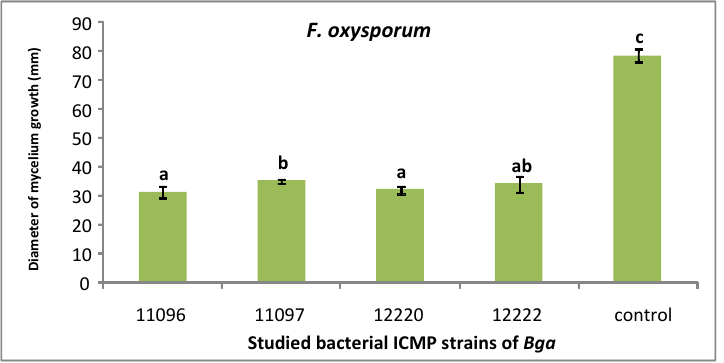
Figure 2. Antifungal activity of volatile organic compounds of Bga strains vs. F. oxysporum (5 days growth). Bars with different letters indicate mean values significantly different at p < 0.05 according to Duncan test. Data are expressed as mean of three replicates ± SD.